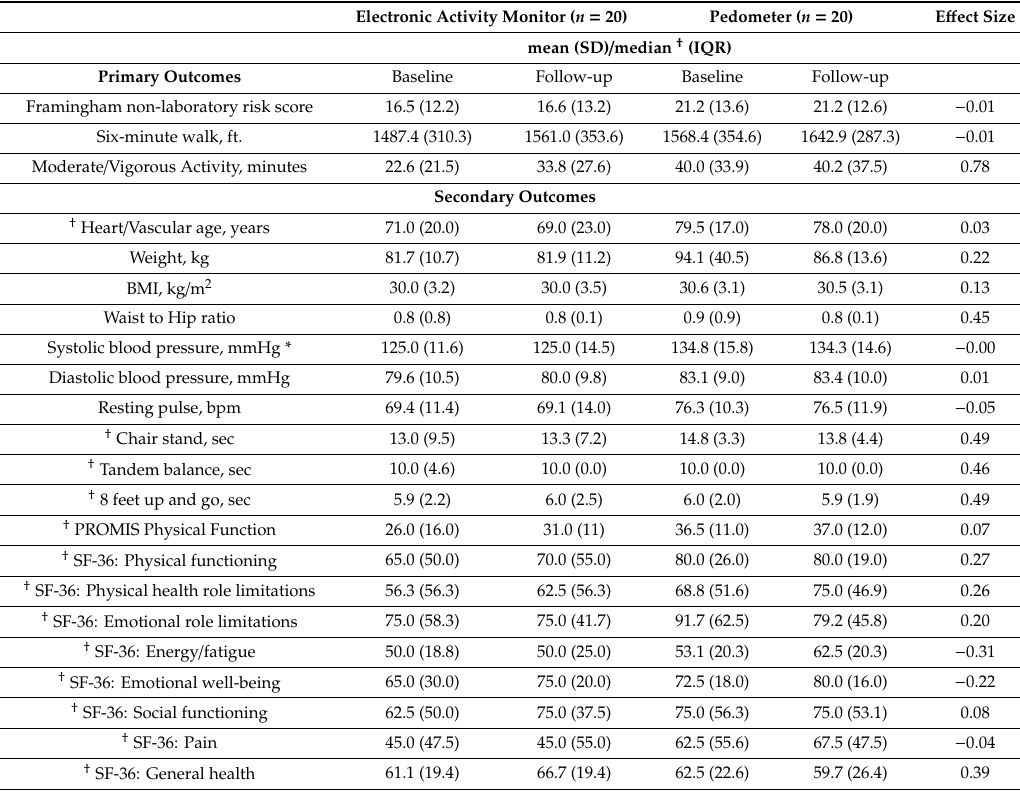
Table 2. Baseline, follow-up values and e ff ect sizes for tested